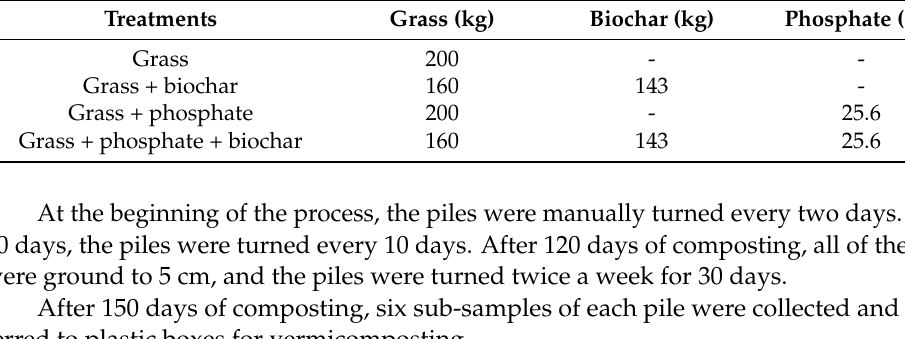
Table 1. Quantities (kg) of each material/input used in the composting piles (2.5 m 3 ). Treatments Grass (kg) Biochar (kg) Phosphate (kg) Grass 200 - - Grass + biochar 160 143 - Grass + phosphate 200 - Grass + phosphate +